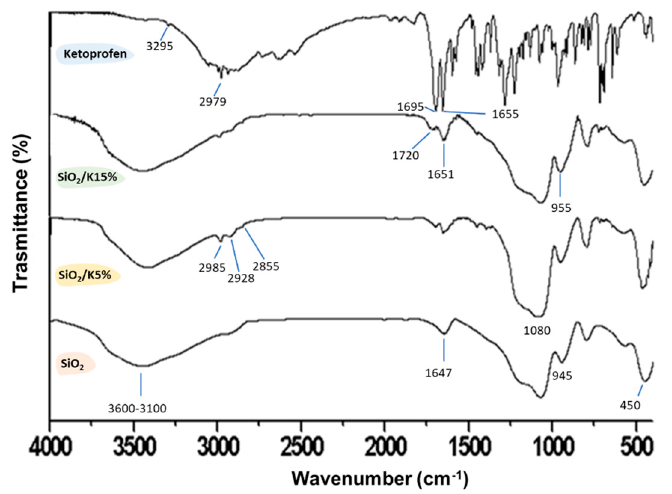
Figure 10. FT − IR spectra of Ketoprofen, SiO 2 /Ketoprofen (5 and 15 wt. %) hybrid materials and pure SiO 2 .